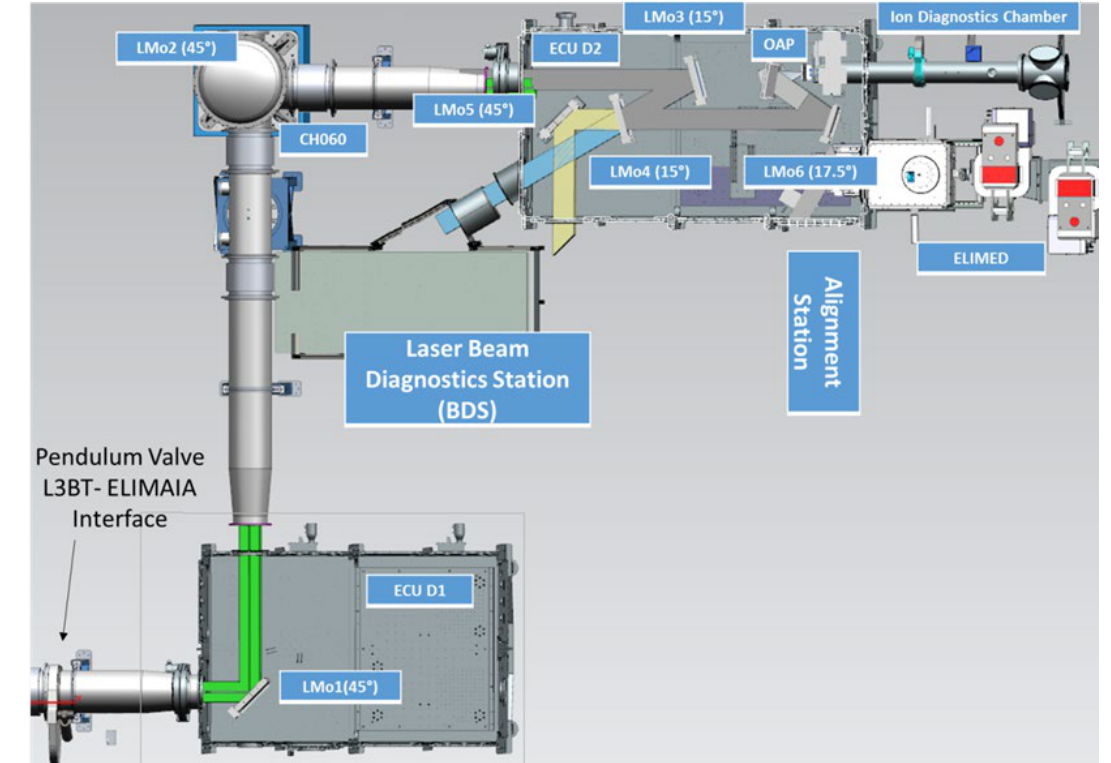
Figure 4. Detailed view of the optical setup arranged to accelerate the ion beams towards the Ion Diagnostics line (Ion Accelerator commissioning setup), including the position of the L3 laser beam, ion diagnostics, and alignment station. The angle of incidence of each mirror in the optical setup is specified. The mirror LMo4 (15°) is a leak mirror and transmits a fraction of the laser energy towards the BDS for online analysis. The last mirror LMo6 (17.5°) is installed to send the beam towards the OAP set on the main axis of the Ion Diagnostics Chamber, but it can be turned by 90deg to send the beam in the opposite direction (assuming that the OAP would be installed on the main axis of ELIMED).